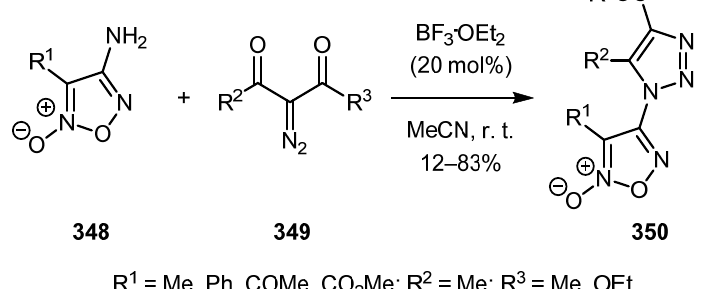
Scheme 85. FeCl 2 -catalyzed Wolff cyclocondensation of amines and α -diazo- β